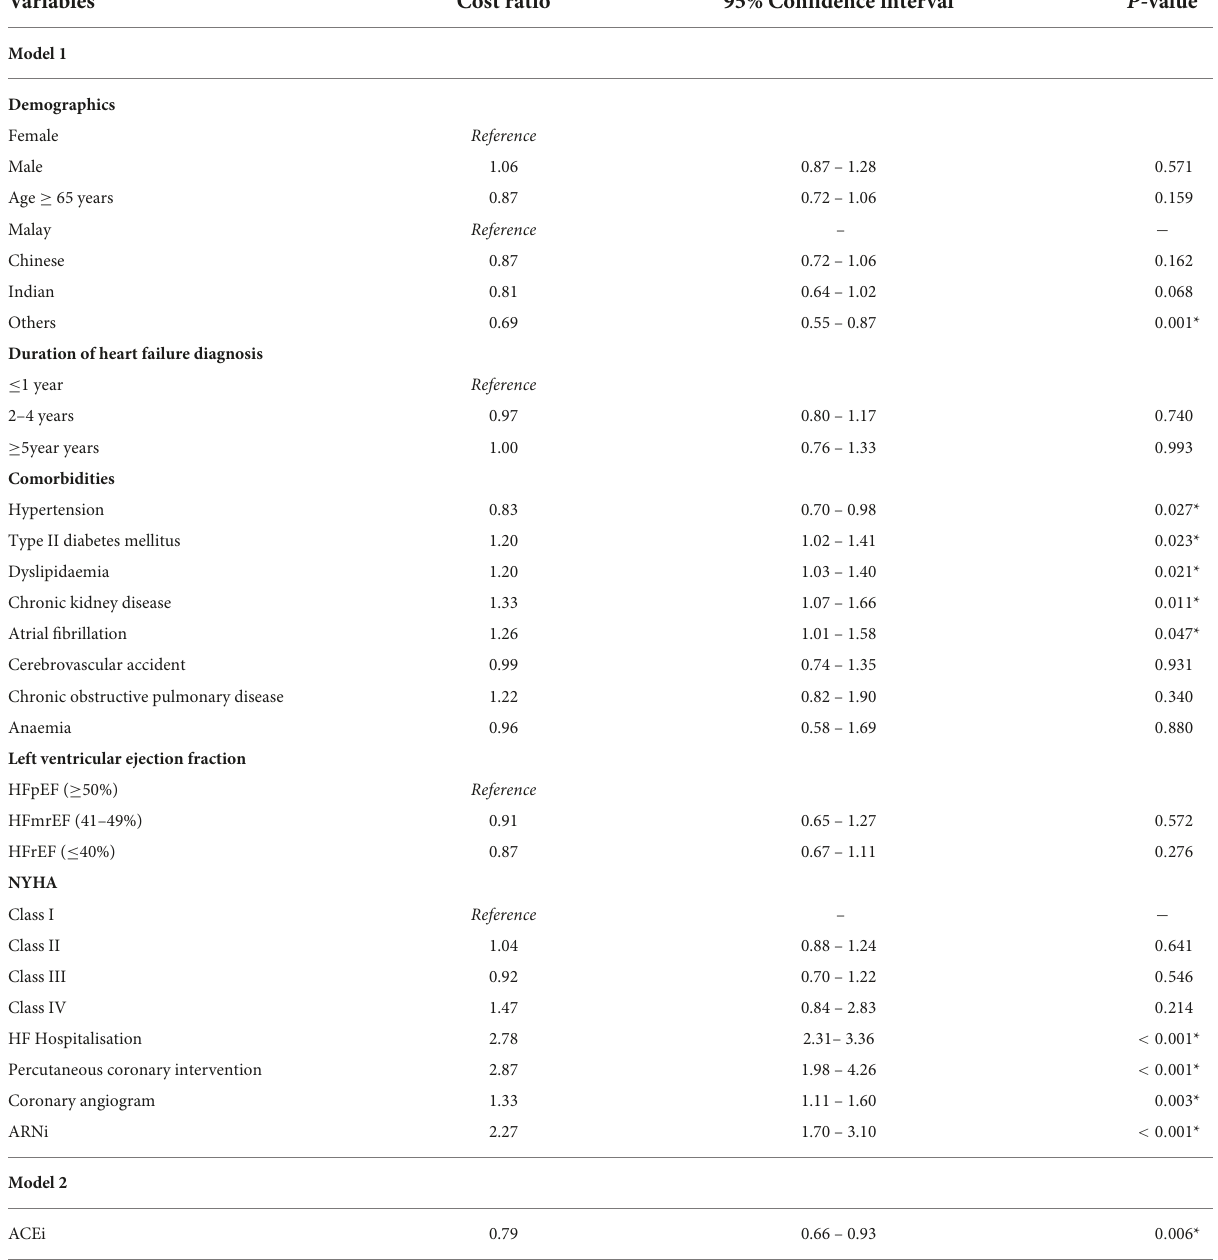
TABLE 6 Predictors of mean annual cost of heart